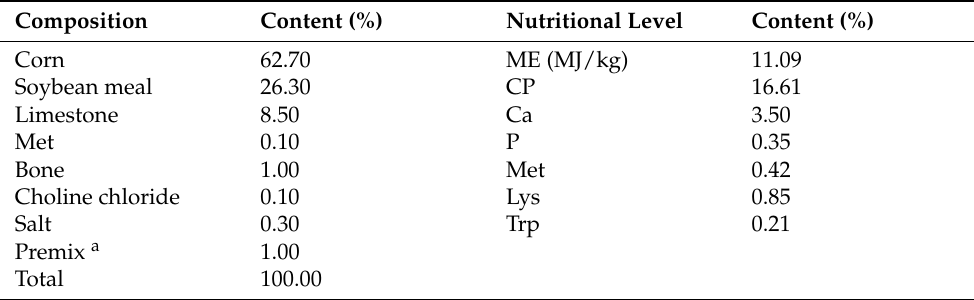
Table 1. Composition and nutrient levels of basal diet (air-dry basis,